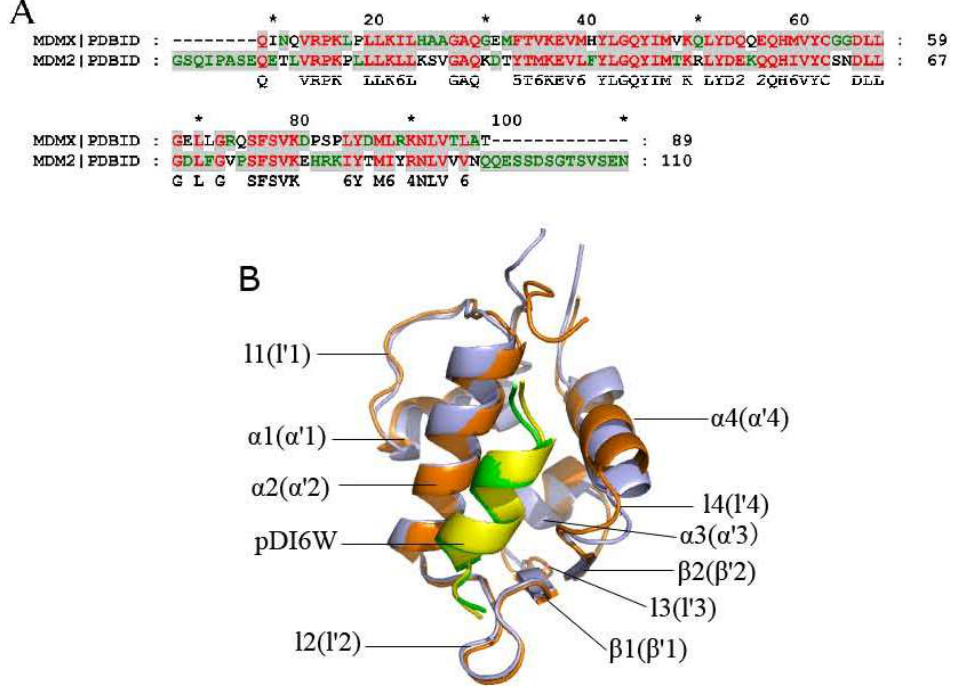
Figure 1. Sequence and structure of the binding domain of MDM2/MDMX to p53. ( A ) The sequence alignment of MDM2 with MDMX; ( B ) Stereoview of superimposed structures of pDI6W-MDM2 (green/orange) and pDI6W-MDMX (yellow/light blue) in a cartoon diagram. The sign “'” represents the second structure belonging to MDMX. In Figure 1B, α β and l represent α -helix, β -sheet and loop,